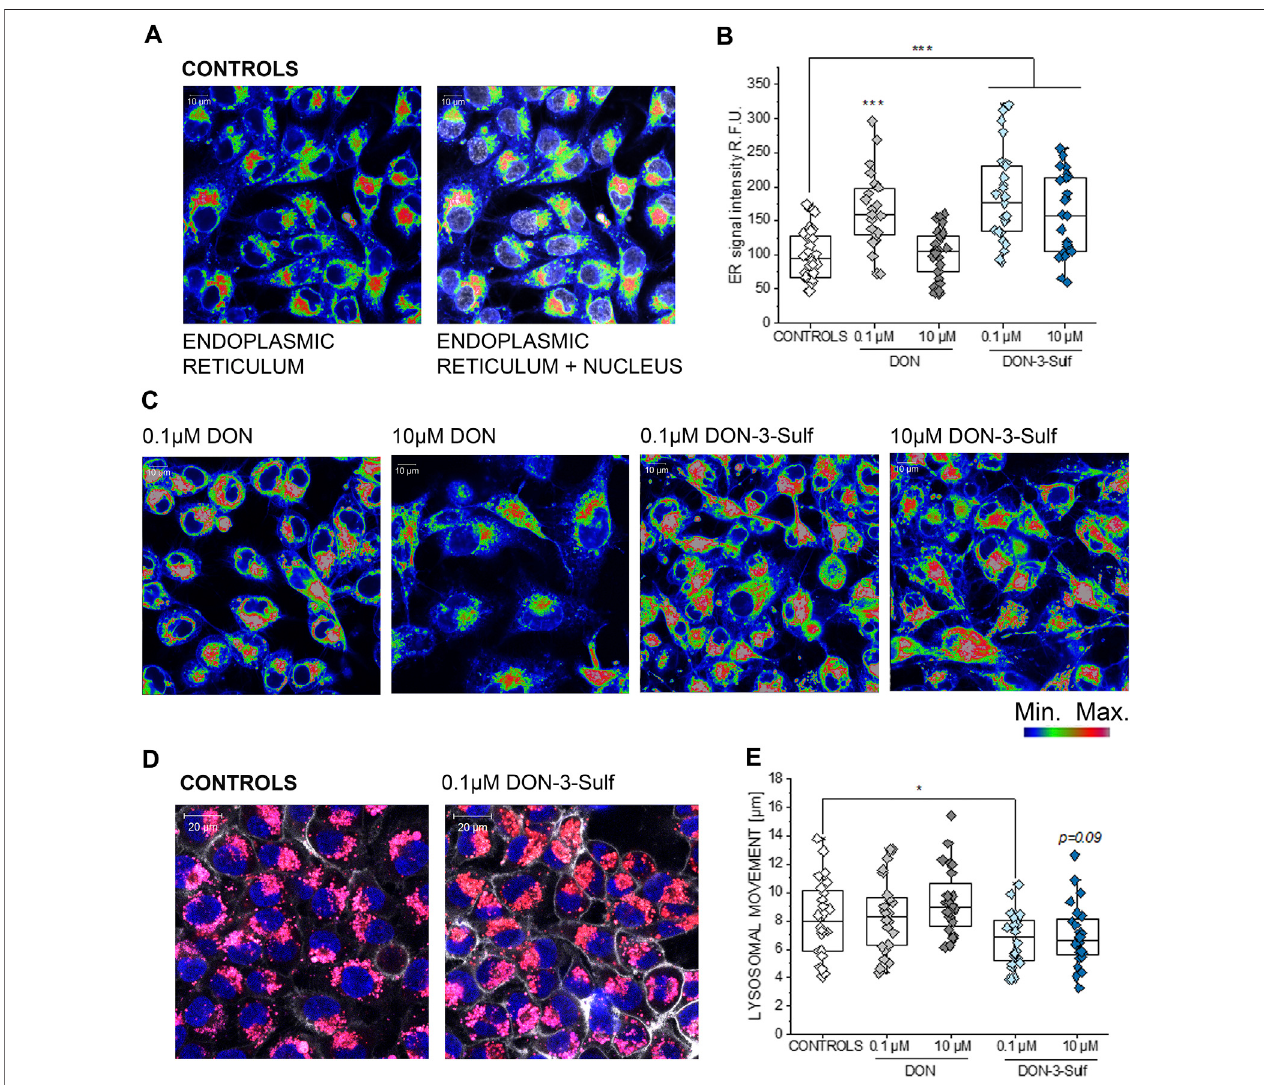
FIGURE 1 | Response of the endoplasmic reticulum (ER) to the incubation with deoxynivalenol (DON) and DON-3-Sulf in T24 bladder cancer cells. (A) Representativeimageoftheappearanceofcontrolcells. (B) Quanti fi cationofthesignalintensityoftheERafter24 hincubationwithDON,DON-3-Sulf,andcontrols.Data areobtainedbythequanti fi cationof n > 25regionofinterest(relative fl uorescentunits;r.f.u.).***indicatessigni fi cantdifferenceincomparisontocontrolsattheStudent ’ s t -test ( p < 0.001; scale bar: 10 µm). (C) Appearance of the ER after incubation with DON and DON-3-Sulf. (D) Evaluation of lysosomes after 24 h incubation with deoxynivalenol (DON) and DON-3-Sulf in T24 bladder cancer cells. Representative images of the appearance of control cells and cells incubated with